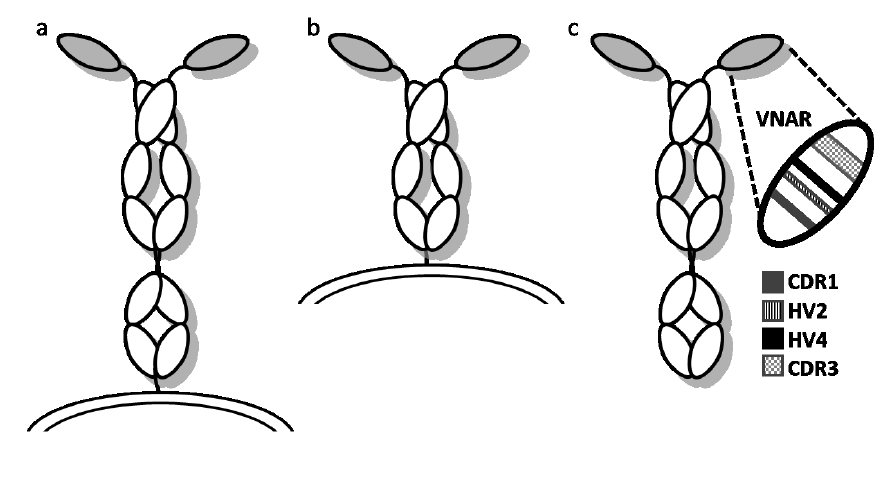
Figure 1. Cartoon depicting the different forms of IgNAR in nurse shark. ( a ) Six domain membrane bound homodimer; ( b ) Four domain membrane bound homodimer; ( c ) Six domain secreted form of IgNAR. Variable (VNAR) domains are shown as shaded ovals; constant domains are white